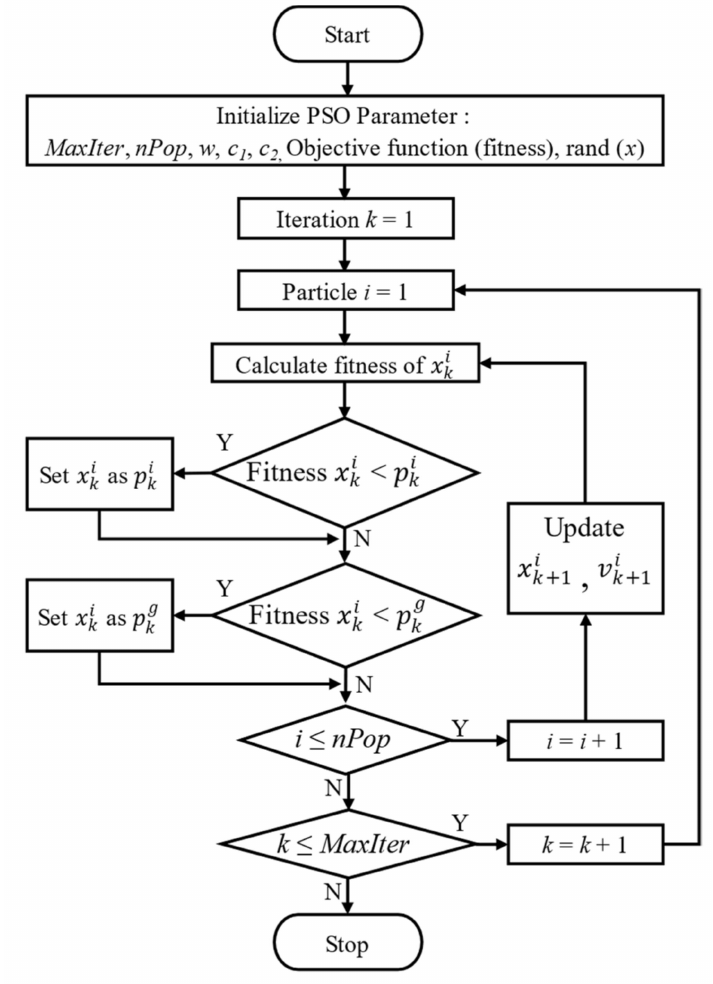
Figure 2. PSO flow